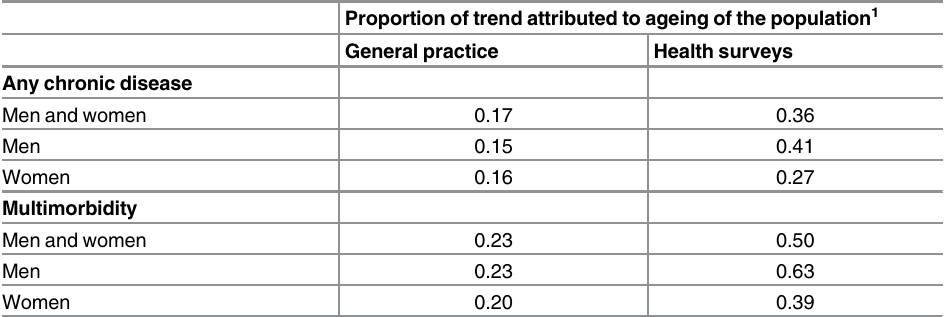
Table 3. Proportion of the trend in the prevalence of chronic diseases and multimorbidity attributed to ageing of the population, retrieved from general practices over the period 2004 – 2011 and health surveys over the period 2001 –